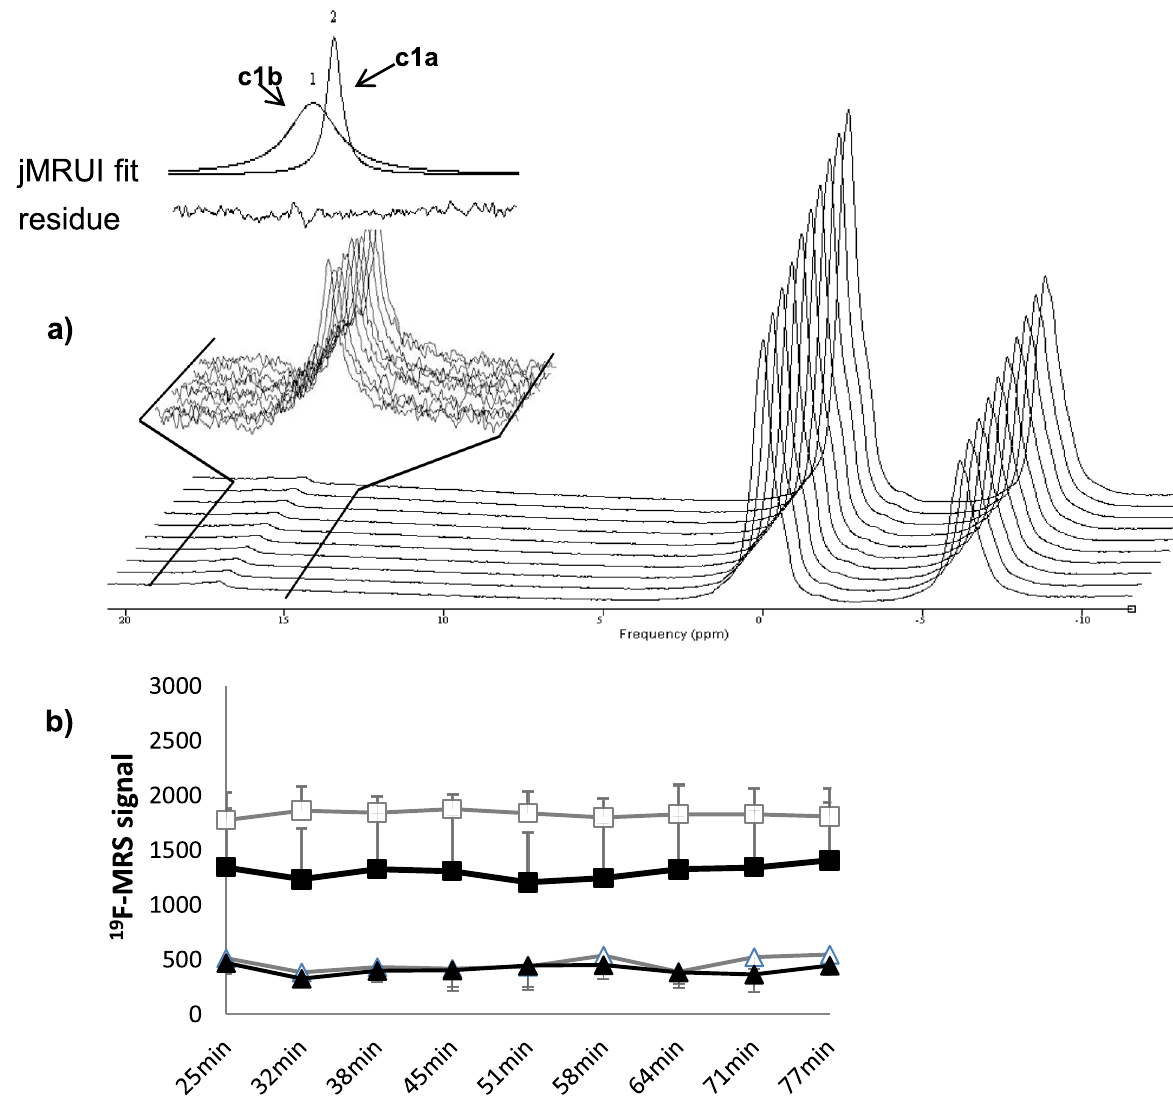
Figure 6. Effects of 11β-HSD1 inhibition on c1a and c1b in rat liver in vivo. (a) Sequential (front to back) in vivo 19 F-MRS spectra in rat liver after gavage of 15 mg/kg of c1a post administration of a weight matched dose of vehicle. 800 repetitions (400 s) per spectrum were used to allow fine monitoring of signal change over time. 19 F-MRS signal from c1a and c1b were detected (zoomed section on left hand side of spectra), with low in intensity compared to isofluorane peaks. (b) Peak areas for c1a and c1b measured by 19 F-MRS after oral gavage of c1a in rats pre-treated with Merck 544 (MK544) selective 11β-HSD1 inhibitor ( c1a black squares, c1b black triangles) or vehicle ( c1a white squares, c1b white triangles). Data are mean ± SEM from n = 3 per group. The time shown is between c1a gavage and the start of the scan for each spectrum (aligned ± 2 min). Scan time per spectrum was 400 s (6 min 40 s). There were no statistically significant differences in amount of metabolite formed or ratio of substrate to product. However, by repeated measures ANOVA 19 F-MRS signal of the substrate ( c1a ) on Merck 544 group was lower than for the control group (p <